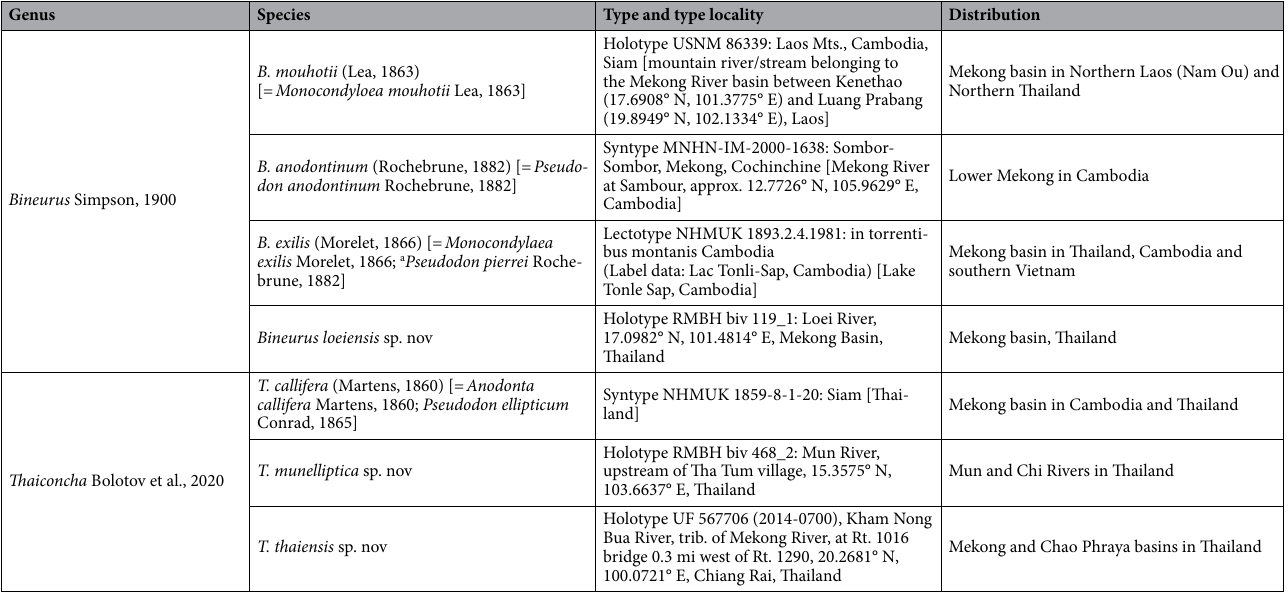
Table 2. Taxonomic review of freshwater mussel taxa in the genera Bineurus and Thaiconcha from Mekong and Chao Phraya basins. a These nominal taxa were placed to the corresponding genera or to synonymy on the basis of conchological features alone, and they are in need of future molecular